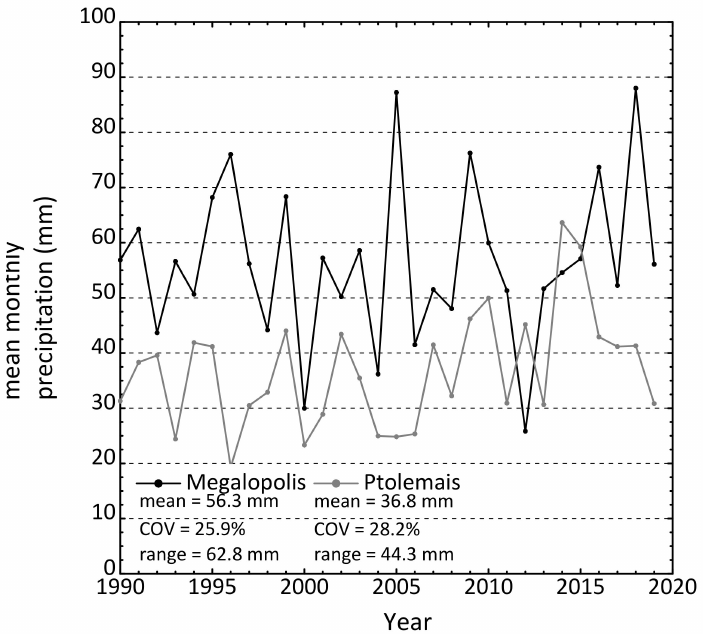
Figure 3. Measurements of the last 30 years of mean monthly precipitation from